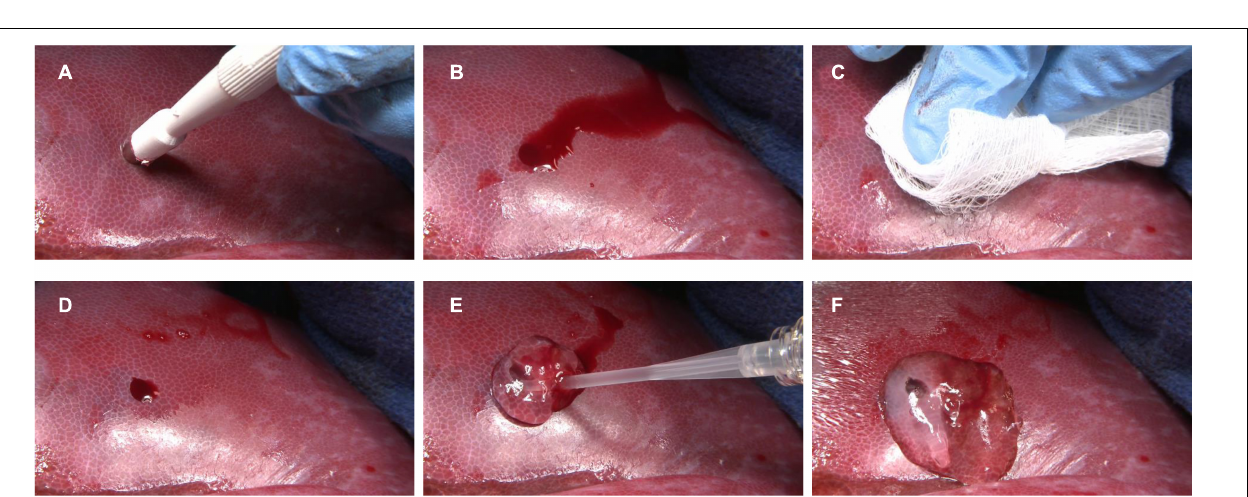
FIGURE 3 | Illustration of RADA16 structure and properties as it is applied to and gels on a wound site. Acidic aqueous solutions of RADA16 are viscous and exhibit shear-thinning and thixotropic disassembly/reassembly, which allows their easy administration to wound sites through catheters and syringes with viscosity returning immediately after administration. Upon contact with the physiological pH of body fluids including blood and interstitial fluid, the surface net charges of RADA16 nanofibers become zero resulting in the physical crosslinking by hydrophobic interactions between neighboring RADA16 nanofibers, so that RADA16 solution forms in situ hydrogels on the wound site and act as a physical barrier to bleeding.